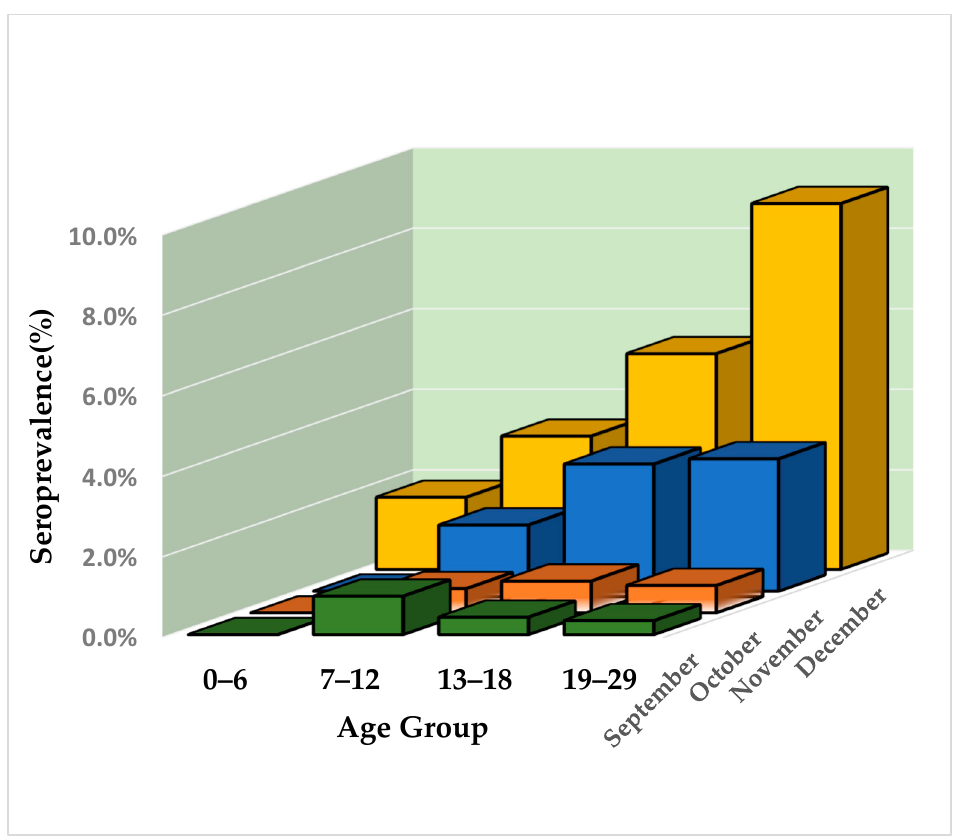
Figure 3. Estimated monthly seroprevalence (S1, adjusted for sensitivity and specificity) by age group in individuals <29 years of age from September to December 2020. Table 2. Monthly seropositivity (S3) in five major geographical units.